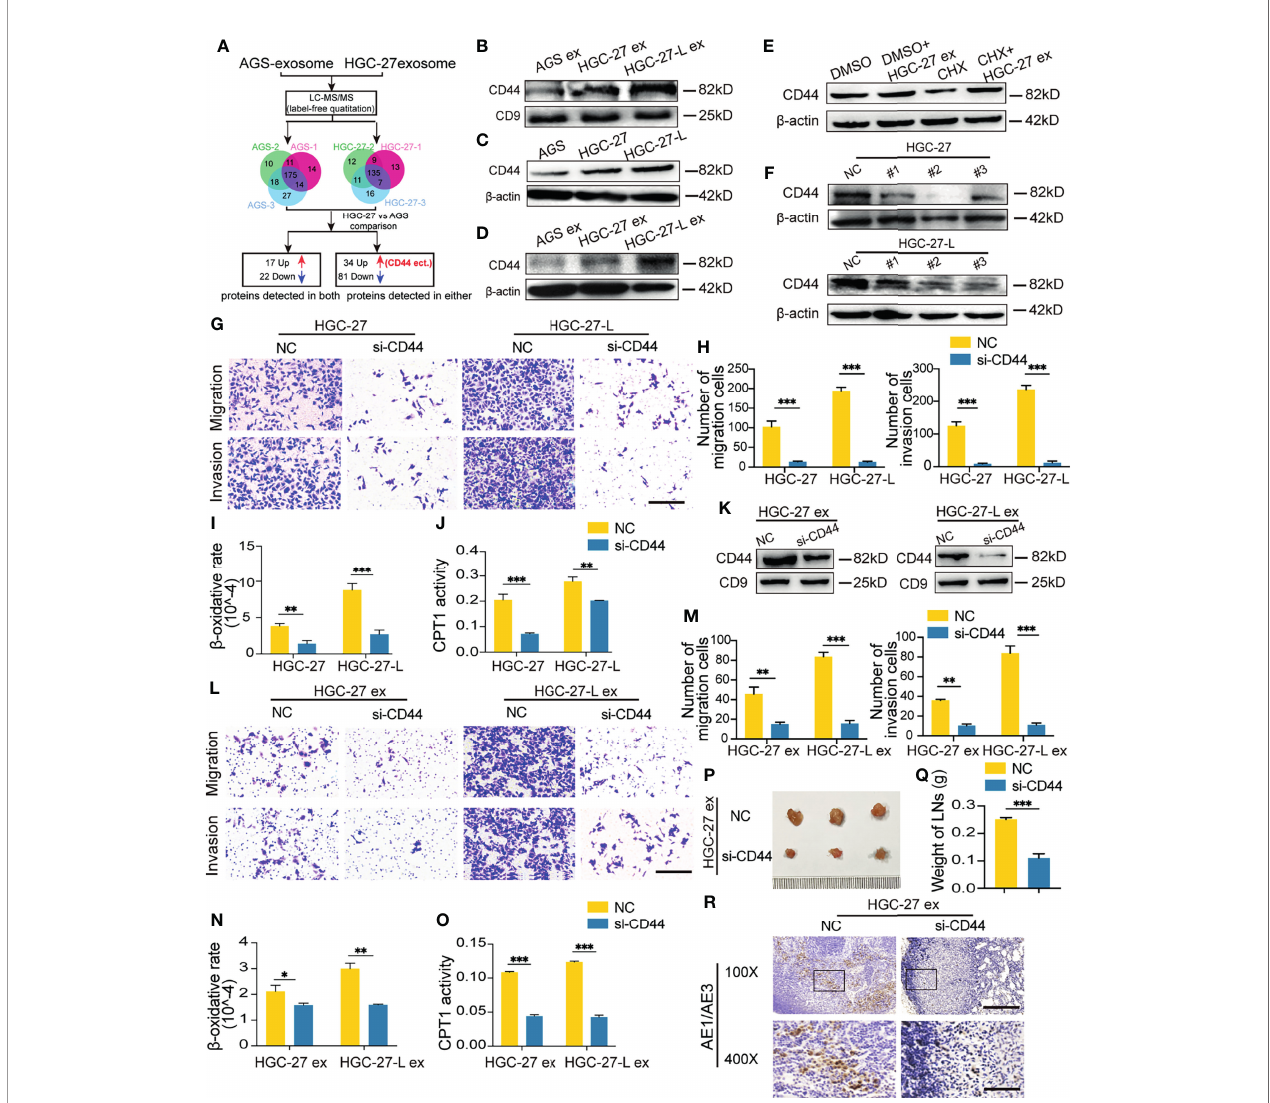
FIGURE 4 | Identi fi cation of CD44 was a critical protein mediating exosome- transmission of LNM phenotype (A) A fl ow chart shows the identi fi cation of differential protein pro fi le between HGC-27-exosomes and AGS-exosomes by label-free quantitation; (B) CD44 protein detection in different GC cell-exosomes; (C) Comparison of CD44 protein in GC cells; (D) Change of CD44 protein levels in AGS after treatment with exosomes; (E) Effect of CHX pretreatment on CD44 protein in AGS incubation with HGC-27-exosomes; (F) Screening for the most ef fi cient si-CD44 in HGC-27 and HGC-27-L; (G – J) Effect of CD44 knockdown on the migration and invasion capacity (G, H) and FAO (I, J) of HGC-27 and HGC-27-L; (K) CD44 protein detection in exosomes derived from HGC-27 and HGC-27-L with CD44 knockdown; (L – O) Effect of CD44-less exosomes on migration and invasion capacity (L, M) and FAO (N, O) of AGS; (P – R) Effect of CD44-less exosomes on LNM capacity of AGS in vivo . Ruler unit, mm. CHX, cycloheximide; ex, exosomes. * P < 0.05; ** P < 0.01; *** P <